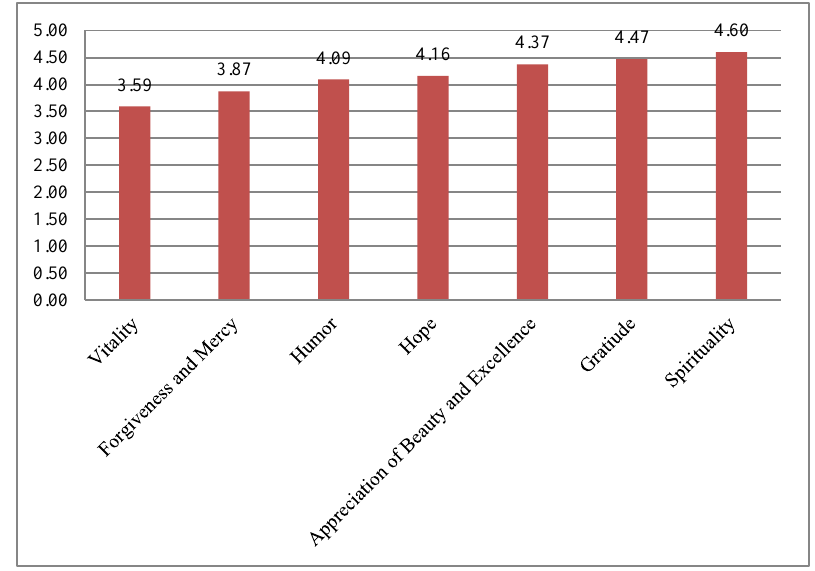
Fig. 7. 6th virtue: Transcendence (means, rated on a 5-point scale,